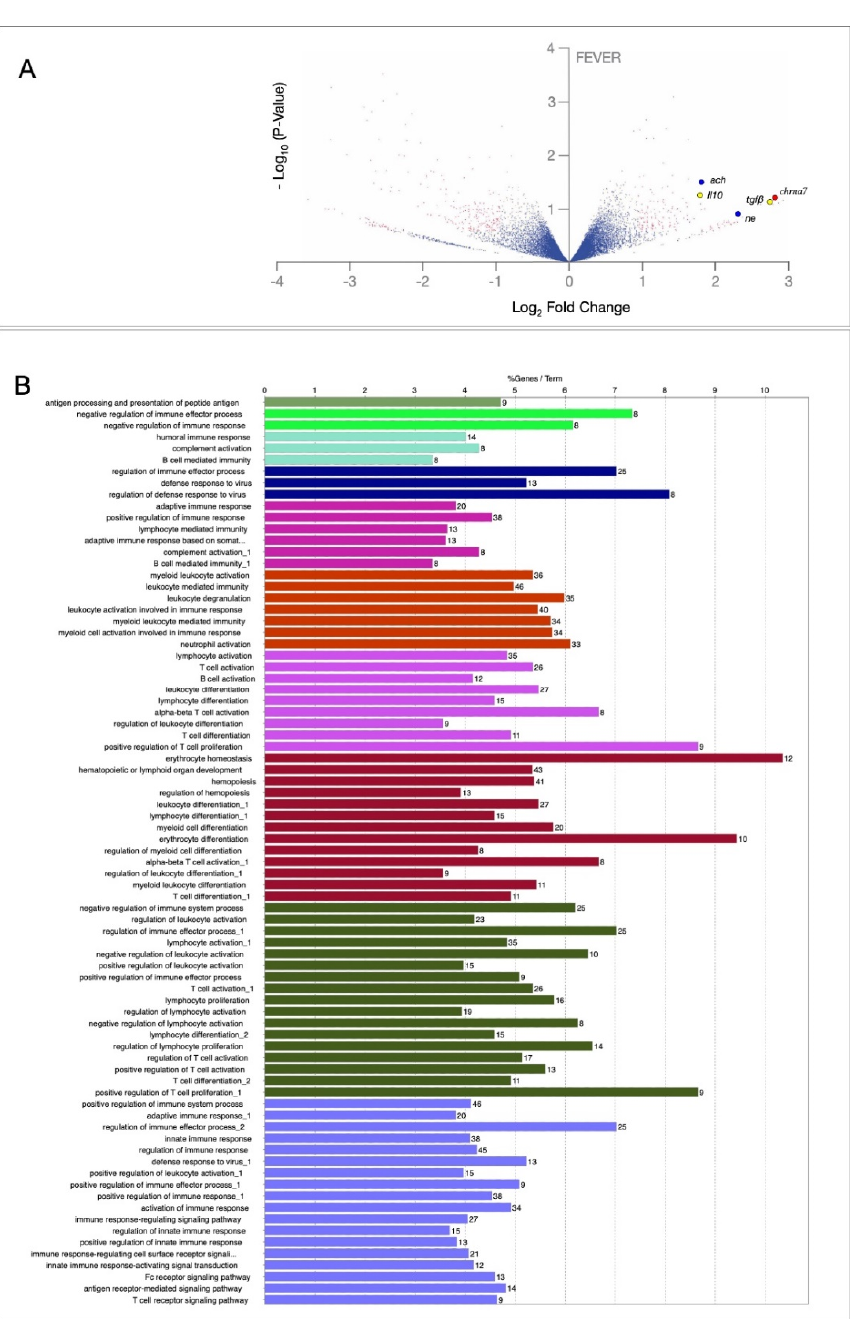
Figure 6. Transcription-wide RNA-Seq screen identifies key inflammatory reflex genes during behavioural fever. ( A ) Volcano plot showing transcripts significantly enriched in spleen following fever induction. Red small dots indicate genes with known functions associated with immune and inflammatory responses and a significant fold change over the background values. Blue, yellow, and red circles highlight members of the inflammatory reflex complex that were significantly enriched such as ache and ne (blue) , tgfβ and il10 (yellow) , and the chrna7 (red) transcripts . ( B ) Gene ontology enrichment analysis of 761 differentially expressed transcripts (GO-DAVID and ClueGo Cytoscape Plugins) showing the set of immune-related gene functions playing a role during behavioural